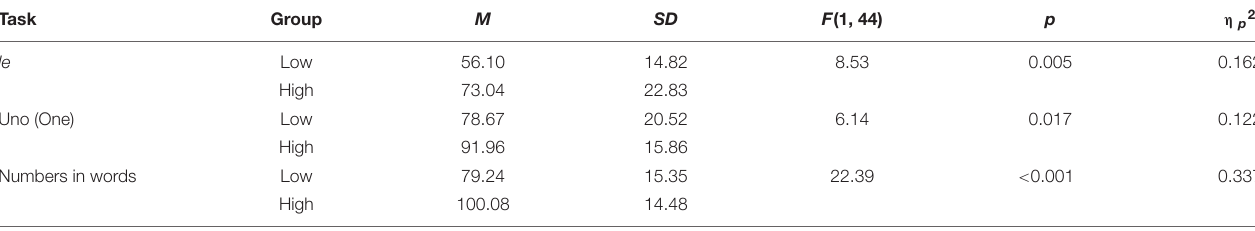
TABLE 1 | Descriptive statistics and results of the univariate tests comparing the two groups on the writing speed tests.